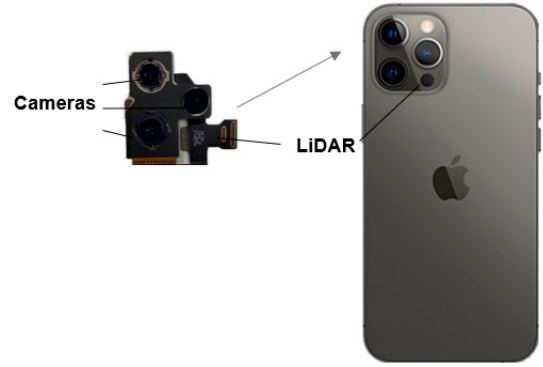
Figure 1. LiDAR system on an iPhone 12 Pro Max.